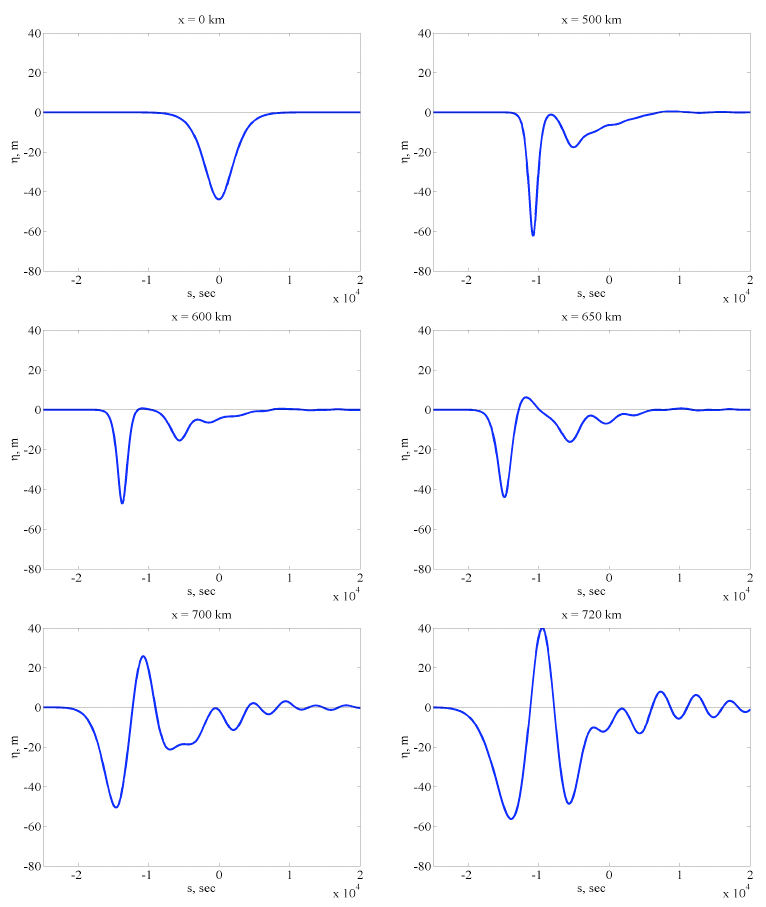
Fig. 18. Transformation of an internal solitary wave along cross-section 2 , initial amplitude 41 m .